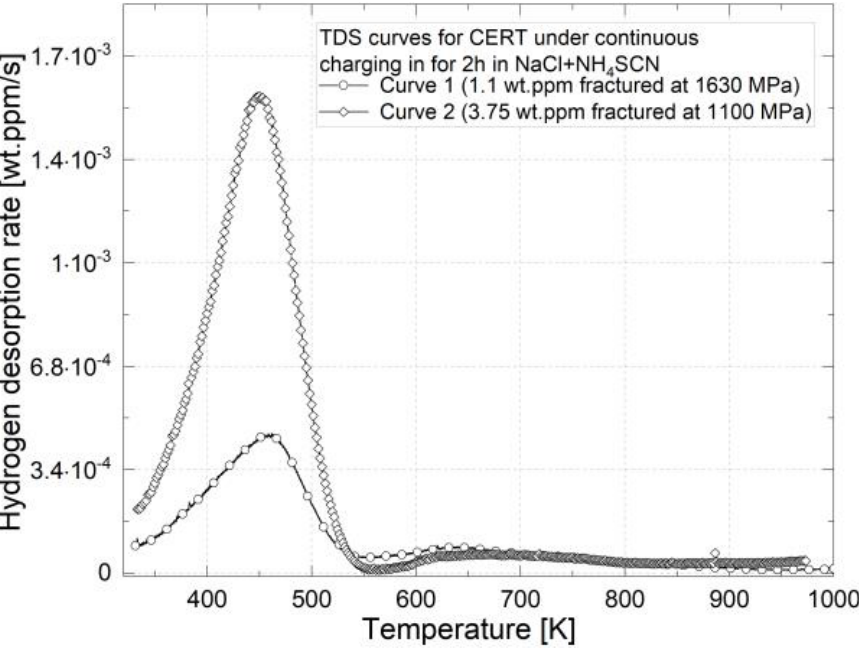
Figure 6. TDS curves for specimens after CERT under continuous hydrogen charging. Specimen fractured at 1650 MPa with corresponding hydrogen concentrations of 1.1 wt.ppm ( curve 1 ) and 1100 MPa with 3.75 wt.ppm ( curve 2 ). Heating rate 10 K/min.